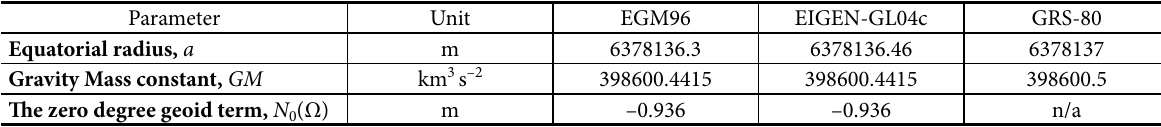
Table 1. The defining constants of the GRS-80, EGM96 and EIGEN-GL04c